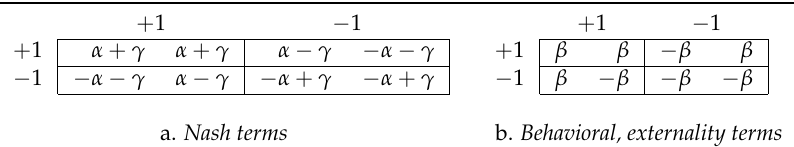
Table 7. Decomposition for a symmetric potential